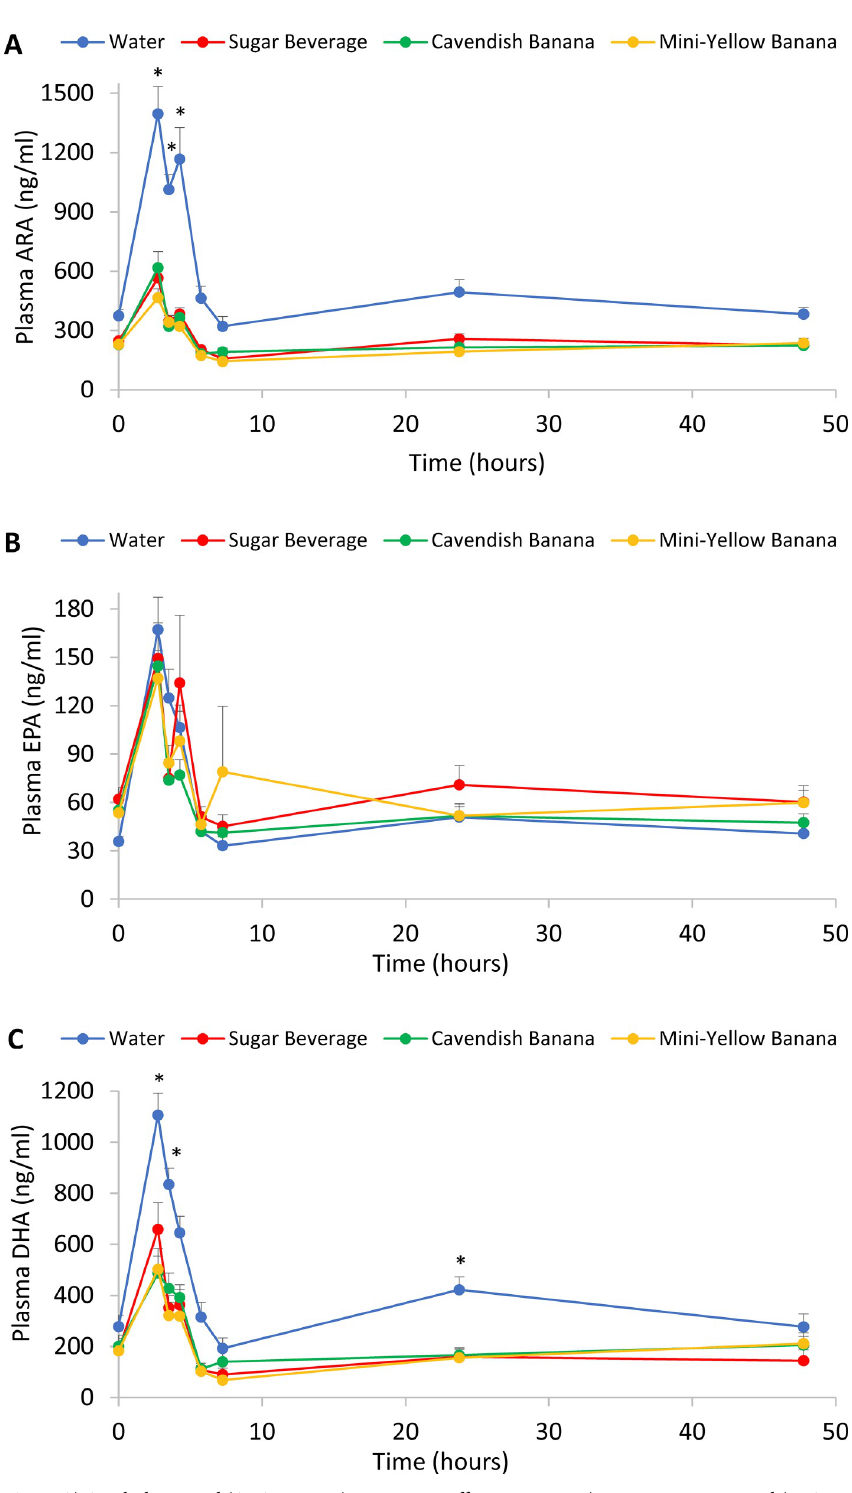
from pre-exercise in the water trial compared to the carbohydrate trials (sugar beverage, Cavendish and Mini-yellow bananas combined). The X axis is on a continuous time scale, with blood sampling time points noted by the markers on the line graphs. Lunch was served after the 1.5 h blood sample (i.e., at 4.25 h on the time